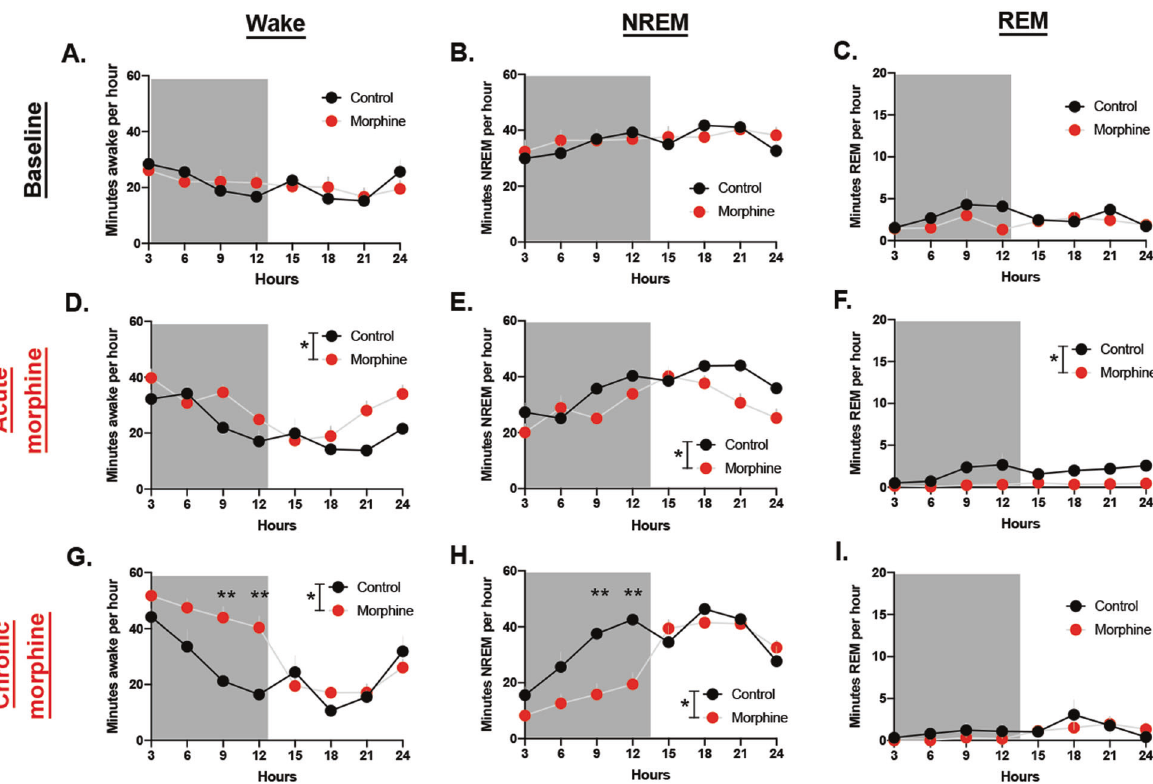
Fig. 2 Morphine increases wake during the dark cycle. A Minutes awake per hour at baseline. B Minutes in NREM per hour at baseline. C Minutes REM per hour at baseline. D Minutes awake per hour at acute morphine timepoint. E Minutes NREM per hour at acute morphine timepoint. F Minutes REM per hour at acute morphine timepoint. G Minutes awake per hour at chronic morphine timepoint. H Minutes NREM per hour at chronic morphine timepoint. I Minutes REM per hour at chronic morphine